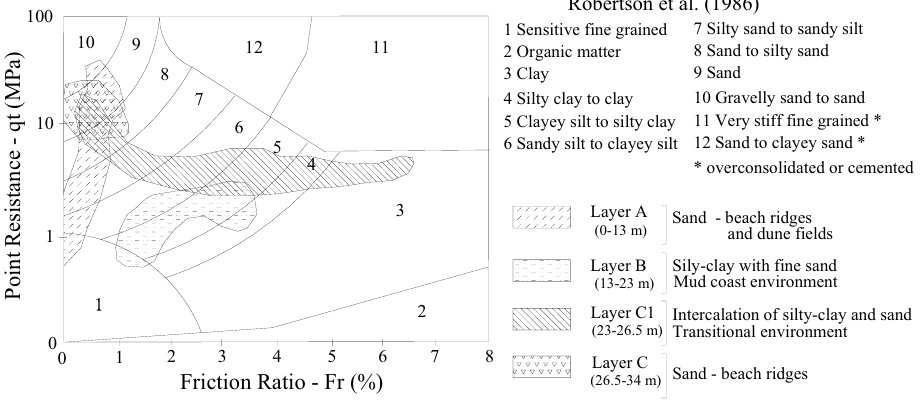
Fig. 9 – Robertson et al. (1986) classification chart and Paranaguá site sediment